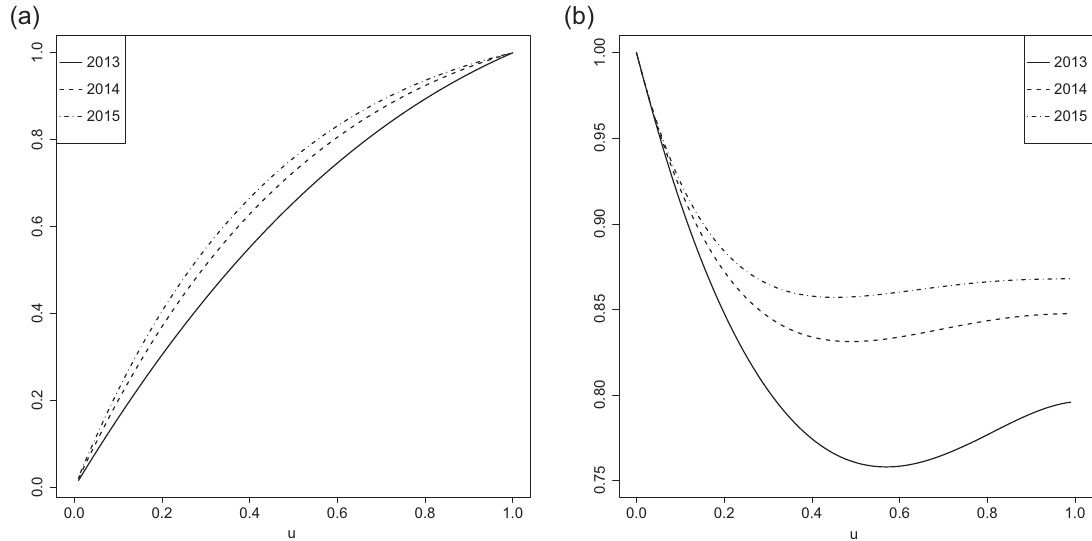
^ d ^ d ¼ B (see Eq. (16)). (b) Prob ð U 1